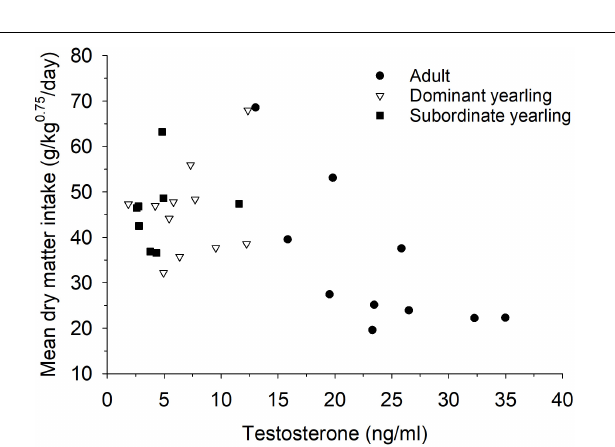
FIGURE 5 | Pair-wise comparisons of percent ingesta-free body fat (IFBFat) and body mass (kg) measured immediately before the rut in mid-Oct and after the rut in mid-Dec for adult ( ≥ 4.5-years old), dominant yearling (1.5-years old and adult male absent), and subordinate yearling (1.5-years old and adult male present) white-tailed deer during 2006–2008 and 2010–2011 (IFBFat only during 2010–2011), Brookings, SD, United States.